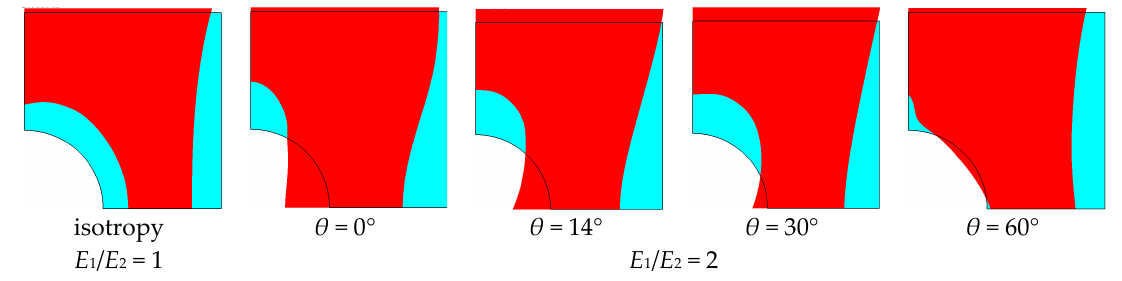
Figure 7. Pre-buckling deformations of the square plate with a circular hole (2 b / L x = 0.4). The scaling factor is 5.